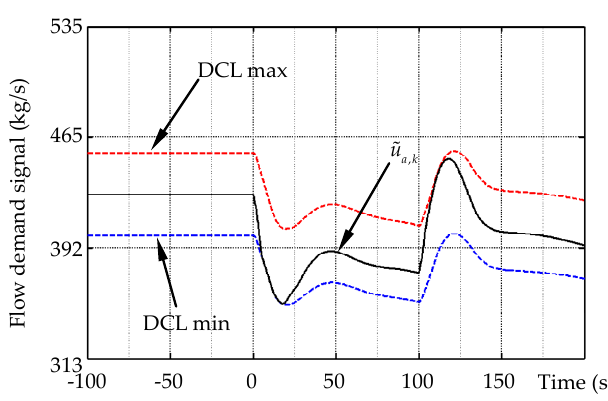
Figure 13. Optimization window for air flow demand signal of DMC for 600-MW plant.